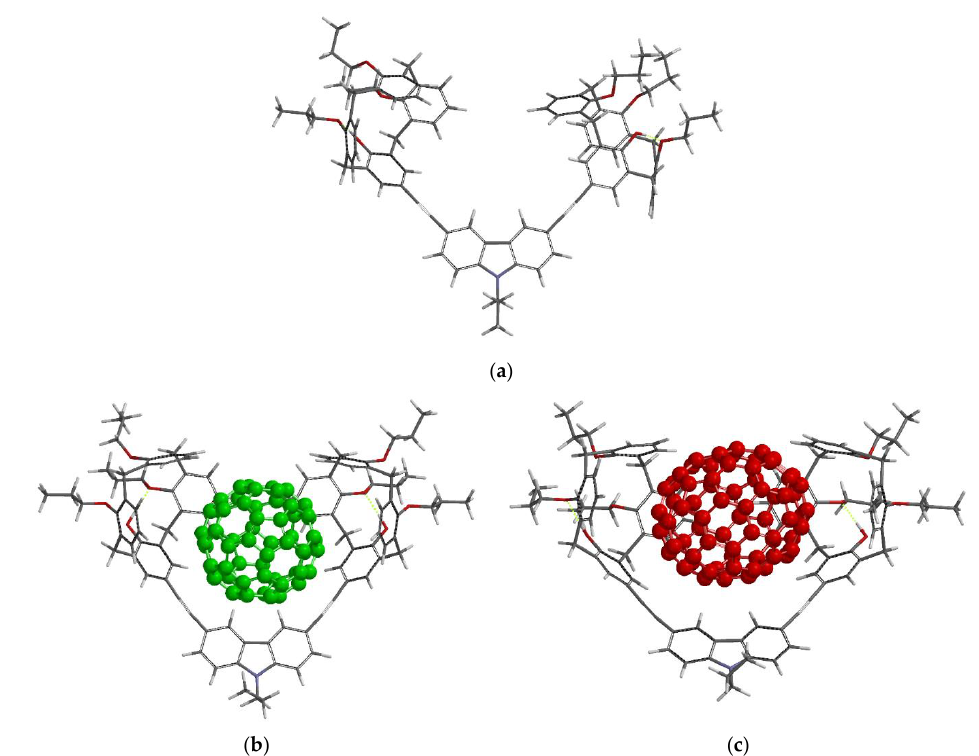
Figure 8. Bis-calixarene-3,6-CBZ ( 4 ) ( a ) and its supramolecular complexes with fullerenes C 60 ( b ) and C 70 ( c ). Geometry optimized structures were obtained by DFT calculations run at B3LYP/6-31G(d) level, and the energies calculated at D3(BJ)-B3LYP/6-311+G(2df,2p) level of theory in vacuum [45,47].